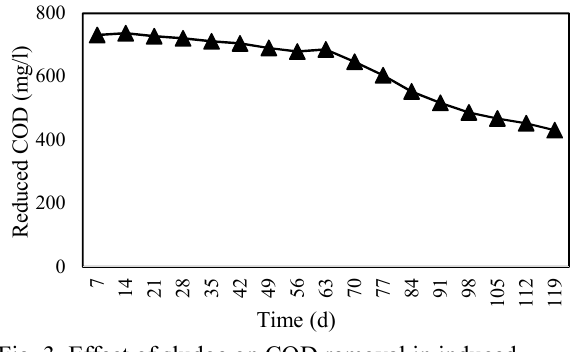
Fig. 3. Effect of sludge on COD removal in induced aeration. No rhamnolipid was